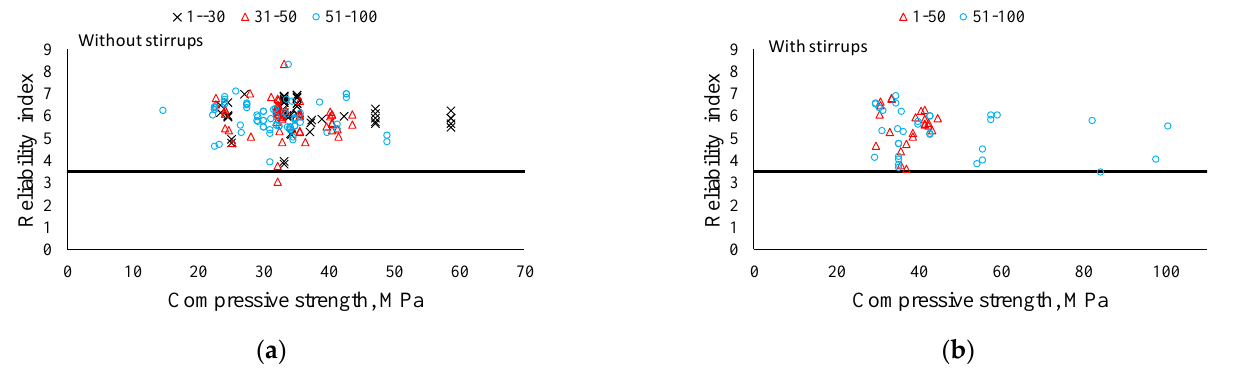
Figure 8. Reliability index values for RCA beams. ( a ) Without shear reinforcement. ( b ) With shear reinforcement.